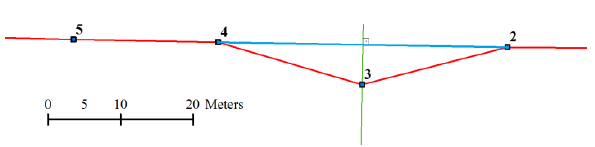
Figure 5. The perpendicular line (green line) at point 3 is